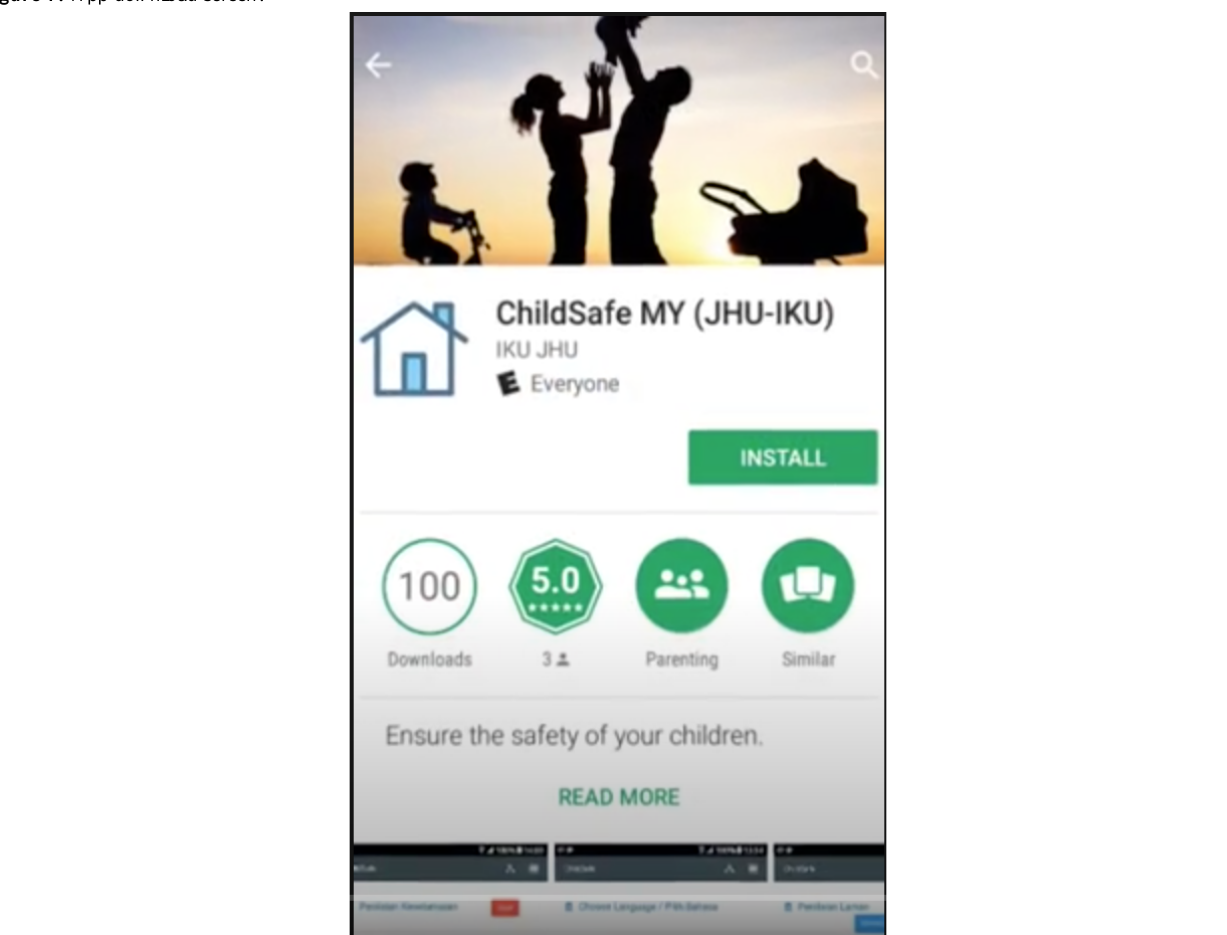
Figure 1. App download